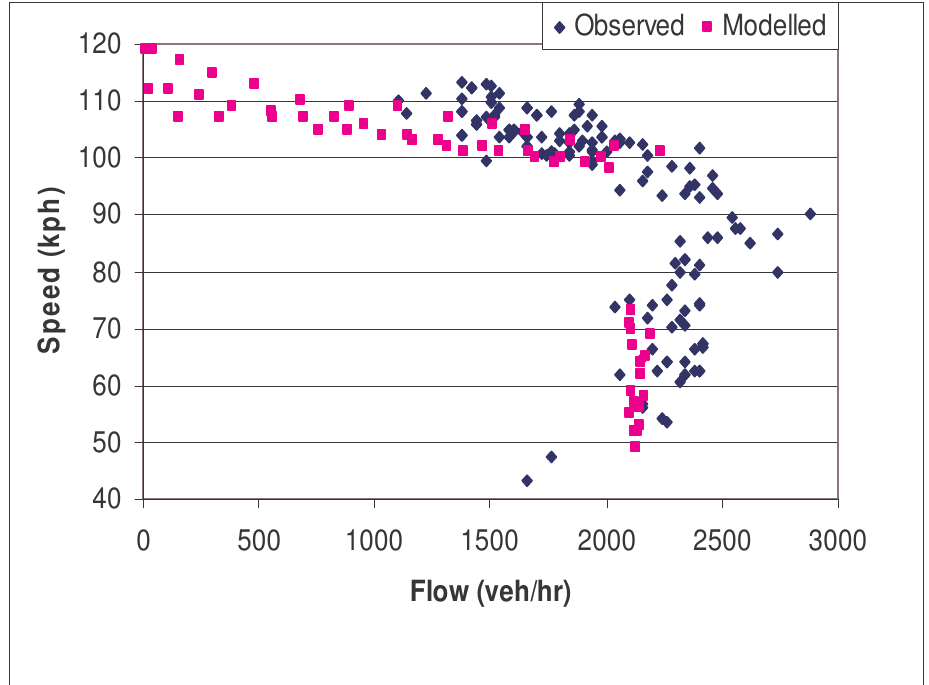
Figure 4: The observed and modelled speed-flow results on the